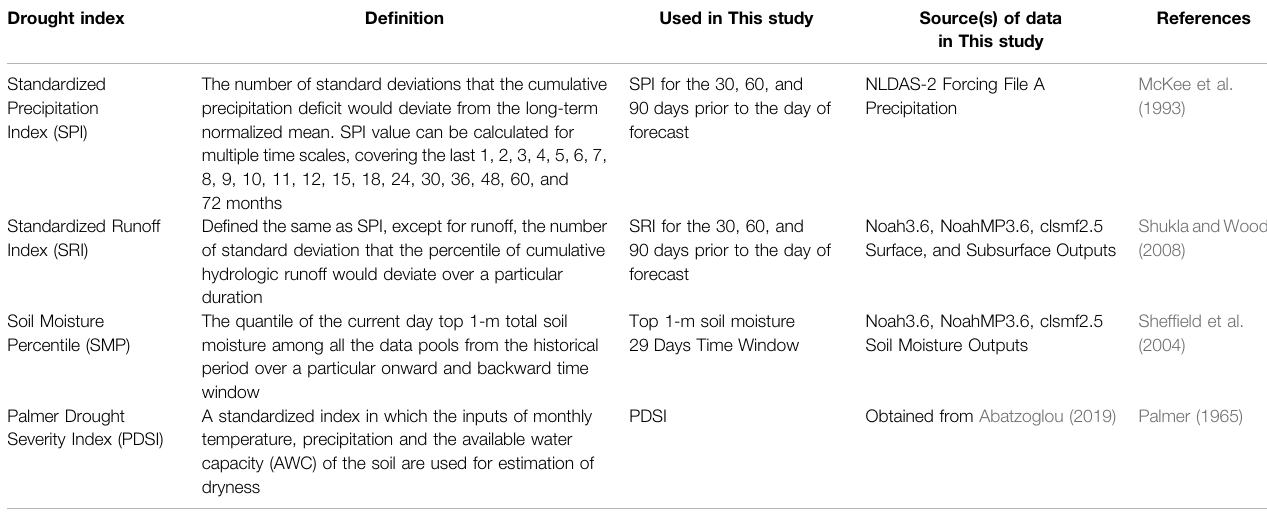
TABLE 2 | Summary of the drought indices.